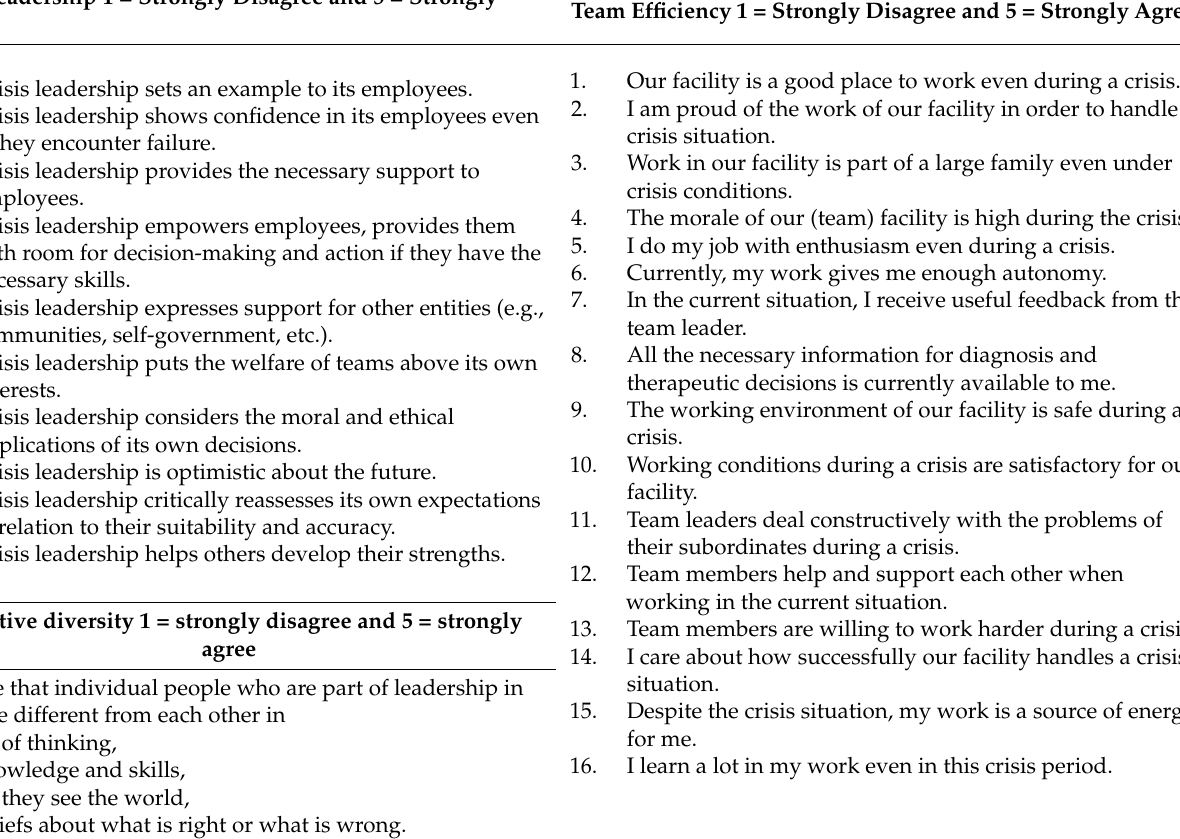
Table 2. Items used to measure variables, source: own